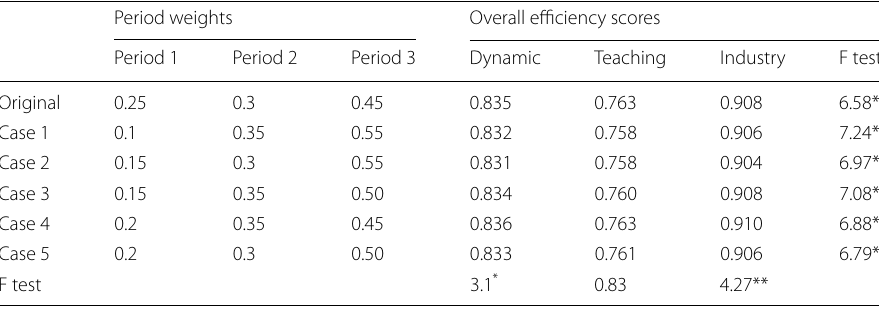
** denotes the significance level at